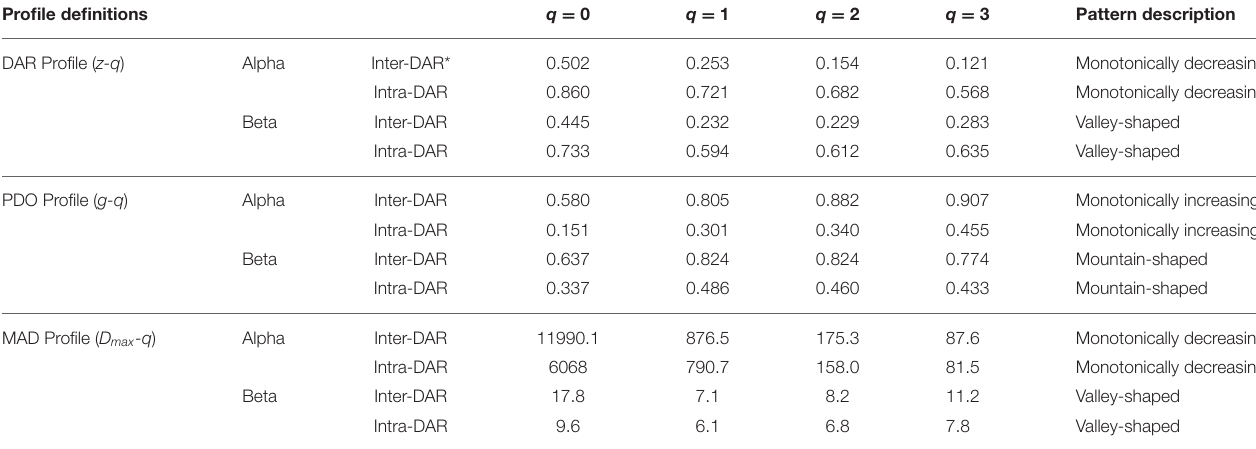
TABLE 3 | Summary of the DAR profile ( z-q ), PDO profile ( g-q ) and MAD profile ( D max - q ) of both inter-DAR* and intra-DAR**